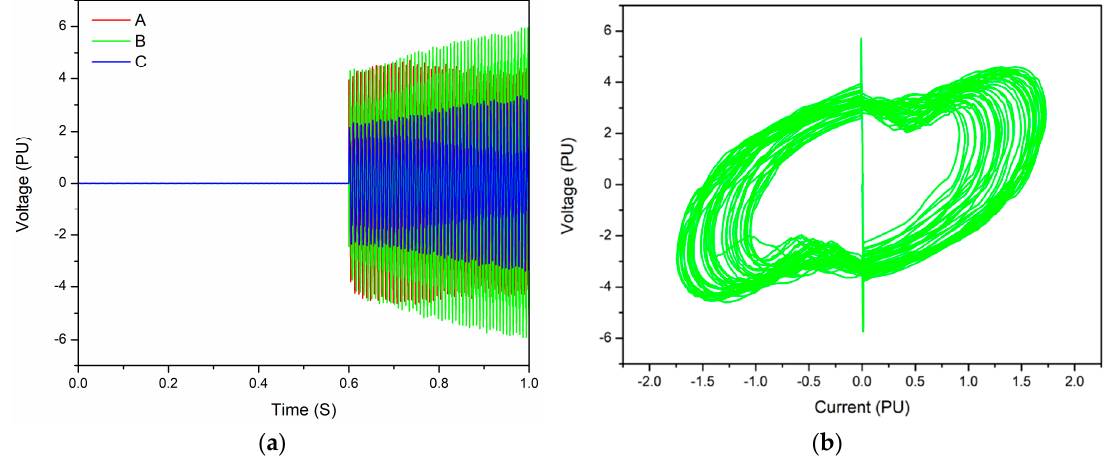
Figure 14. The ferroresonant results during energization at 0.6 secs on the PMSG wind turbine: ( a ) Voltage waveform of phase A, B and C, with phase B having highest overvoltage; ( b ) Phase plane diagram of phase B showing quasi ‐ periodic ferroresonance.